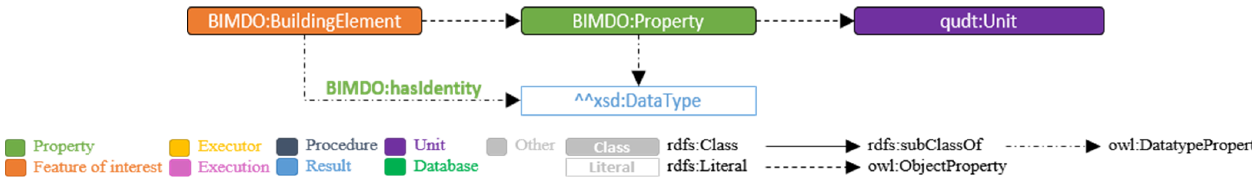
Figure 2. BIMDO describes properties using object properties and datatype